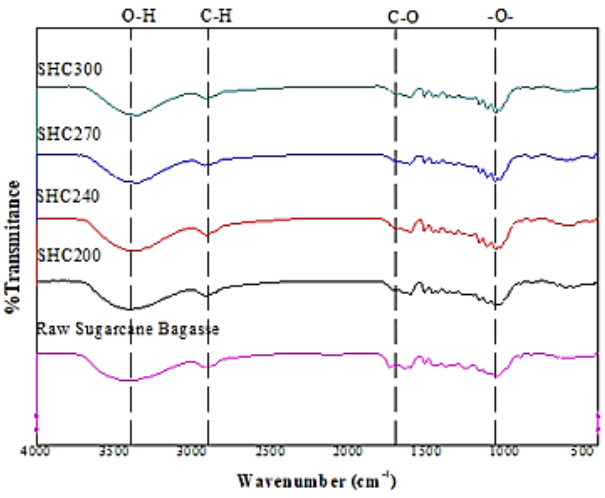
Fig 2. FTIR analysis of Raw Sugarcane Bagasse and Hydrochar at Various Temperatures (200 – 300 o C)